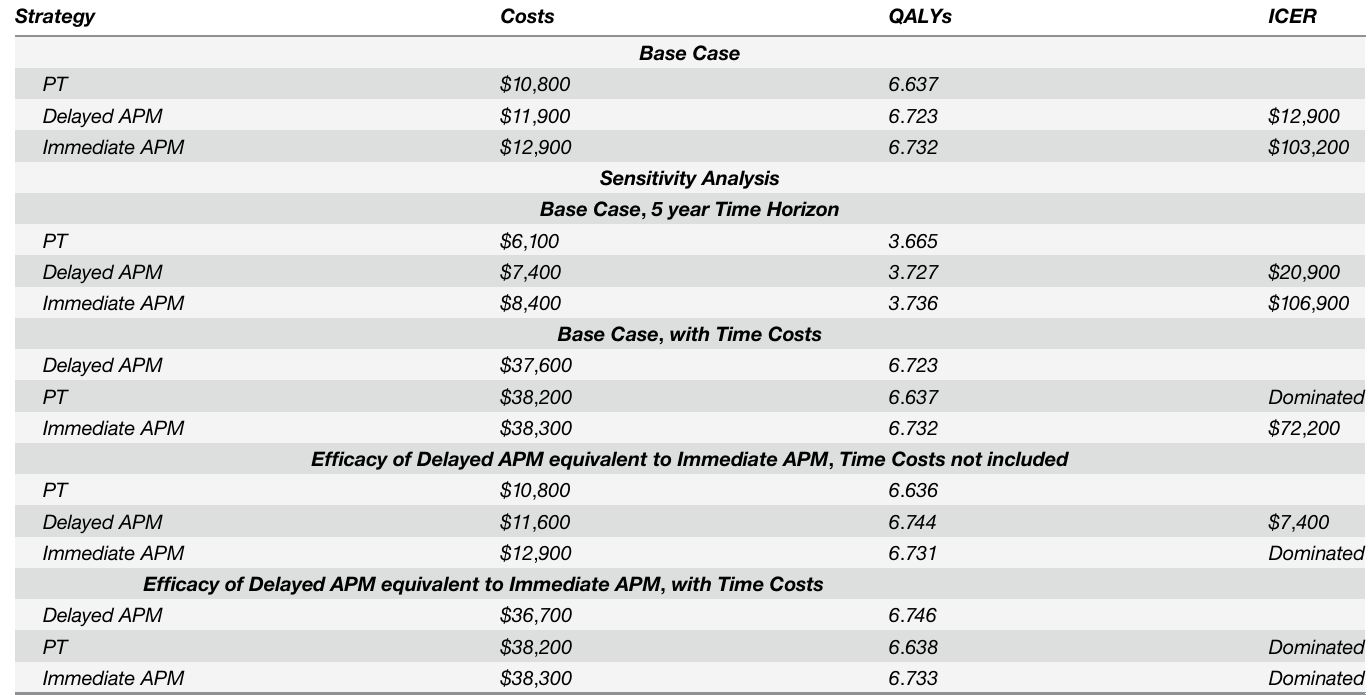
Table 2. Cost-effectiveness of Management Strategies for Meniscal Tear, with Sensitivity